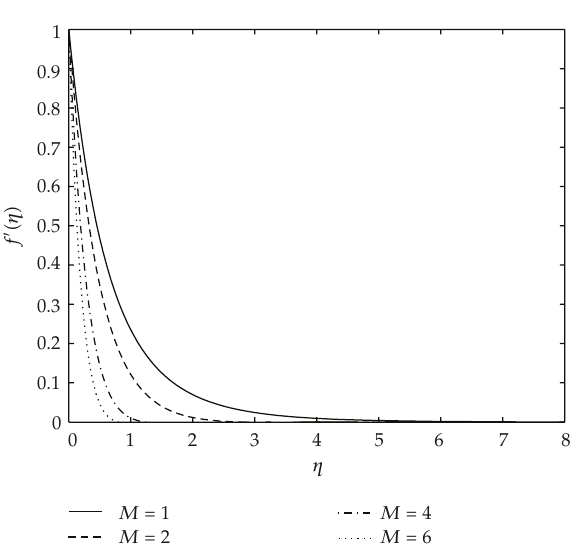
Figure 3: The variation axial velocity distributions with increasing values of M with Pr (cid:5) 0 . 72, m (cid:5) 1, β 1 (cid:5) 0 . 1, β 2 (cid:5) 0 . 1, and S (cid:5) 0 . 8 .